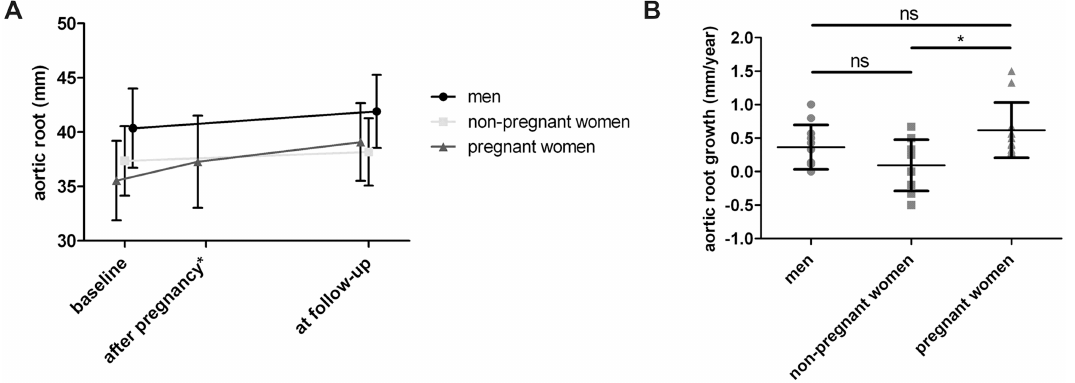
Fig 1. Aortic root characteristics in MFS patients. A. At baseline,aortic root diametersare higherin men comparedto women. Non-pregnant women have higher aortic root diametersat baselinecomparedto pregnantwomen. After